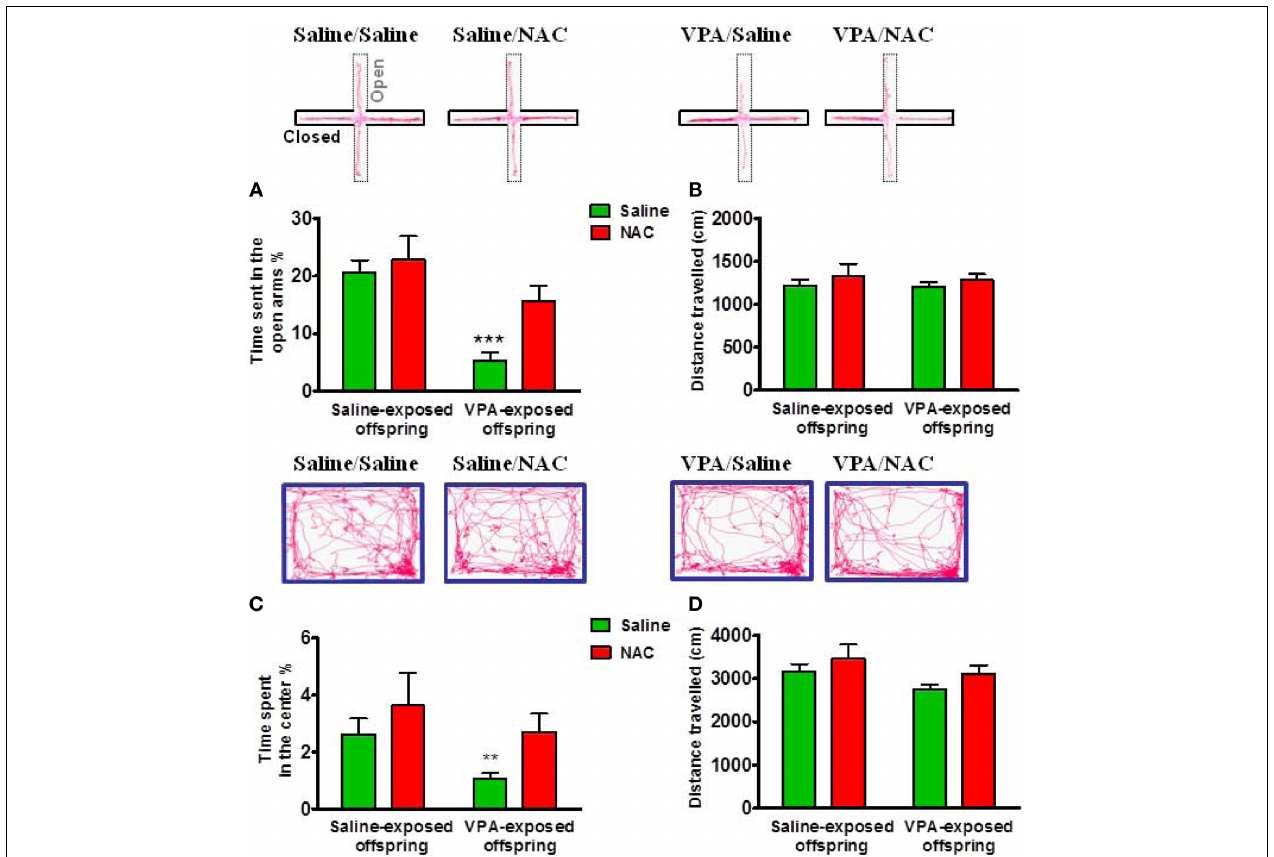
FIGURE 3 | Amelioration of anxiety in the VPA-exposed offspring by NAC. OnP29andP30,ratswereadministeredtheelevatedplus-mazetest(EPM)and the open field test (OF). In the EPM test, the time spent in the open arms (A)